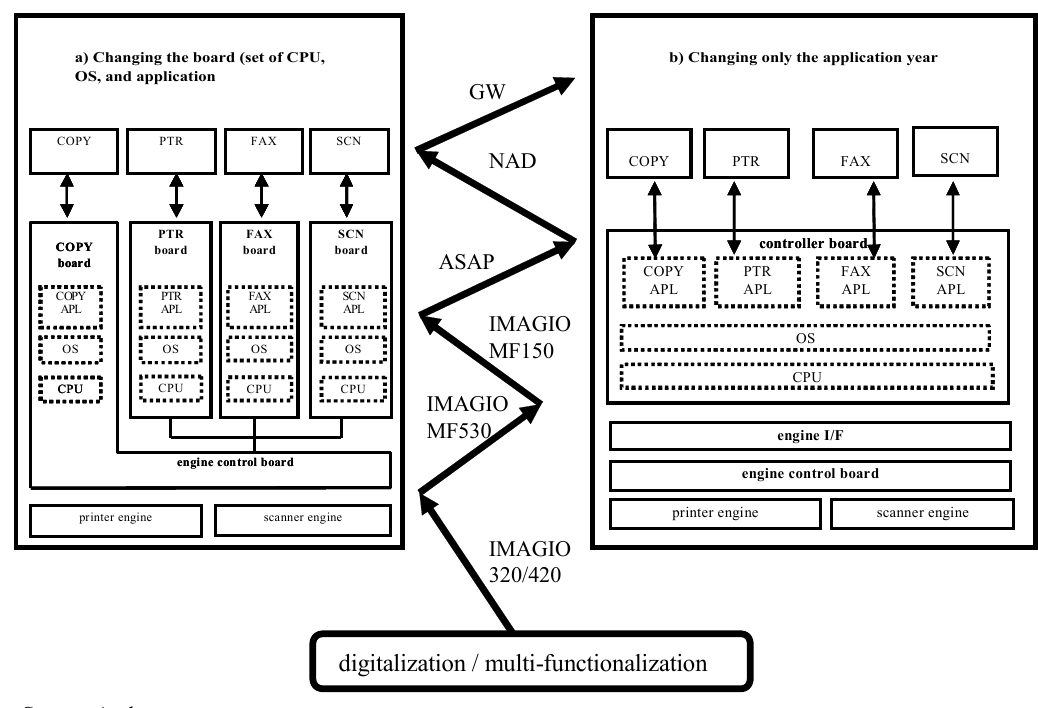
Figure 4. Wavering of firmware architecture of digital